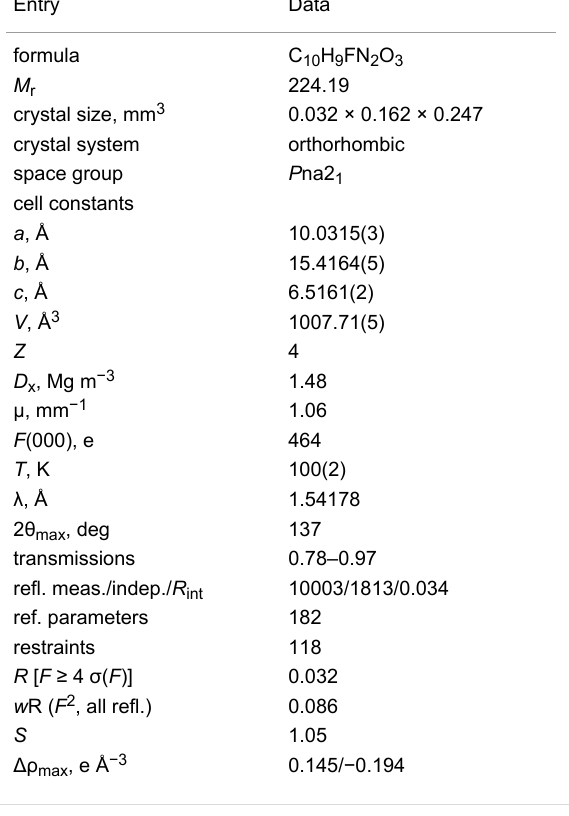
Table 2: Crystallographic data for compound 2c